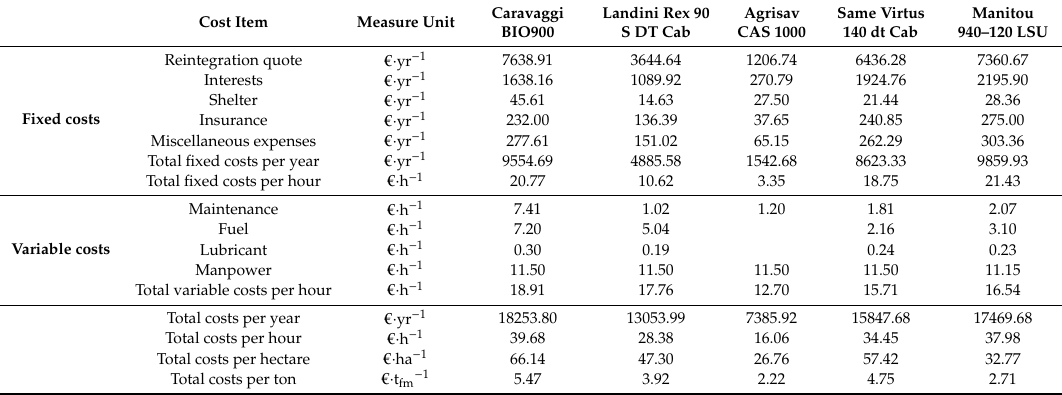
Table 3. Harvesting systems’ costs subdivided into fixed and variable costs for each applied Table 2. Results of the performance and work quality of the stationary harvesting Caravaggio mod. BIO 900.